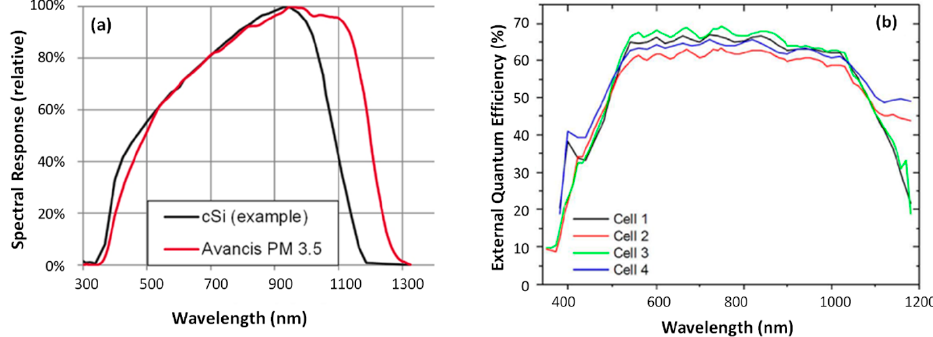
Figure 2. Avancis PowerMax 3.5 CIS cell modules’ spectral performance characteristics. ( a ) Spectral responsivity curve measured relatively to the monocrystalline Si cells. These data are courtesy of Avancis, Inc. (Torgau, Germany), ( b ) External Quantum Efficiency (EQE) of earlier Avancis CIS modules. (Reproduced with permission from [23],) European Commission, 2007.